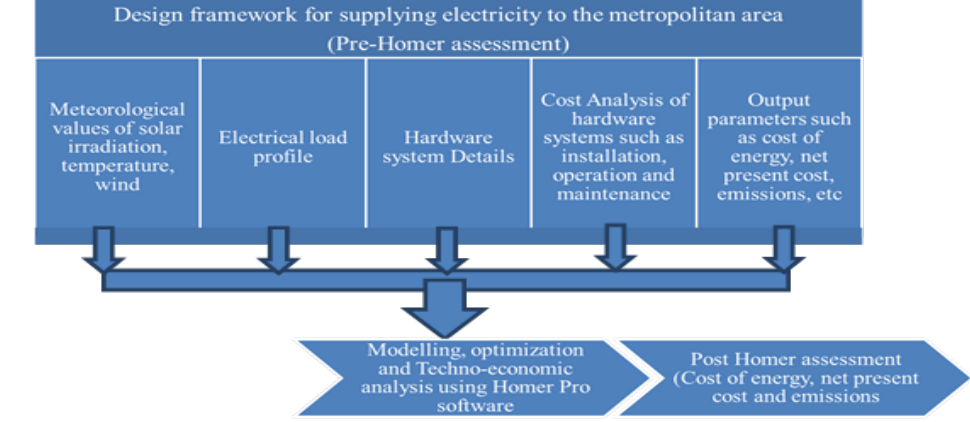
Figure 2. The suggested HRES implementation architecture utilizing